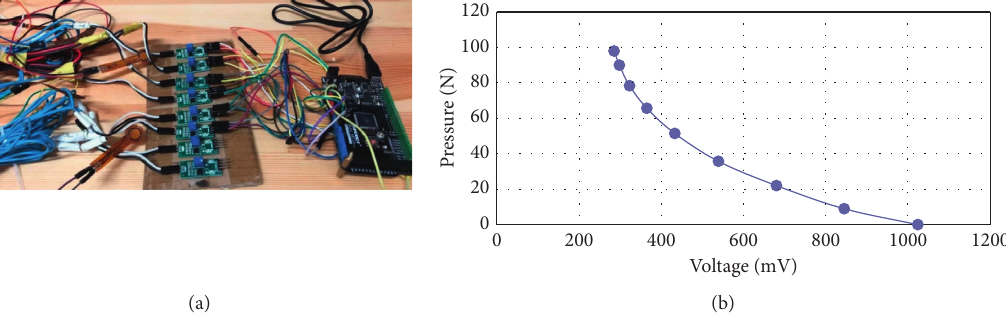
Figure 15: (a) Hardware for data reading. (b) Calibration of force and voltage.